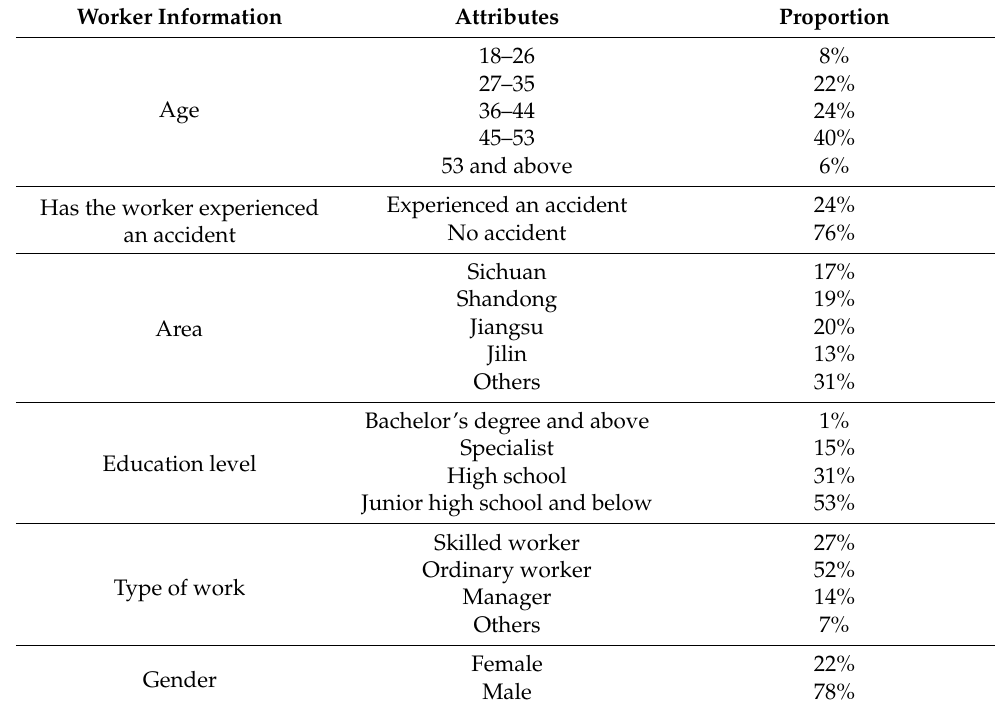
Table 9. Statistics of survey objects’ information.